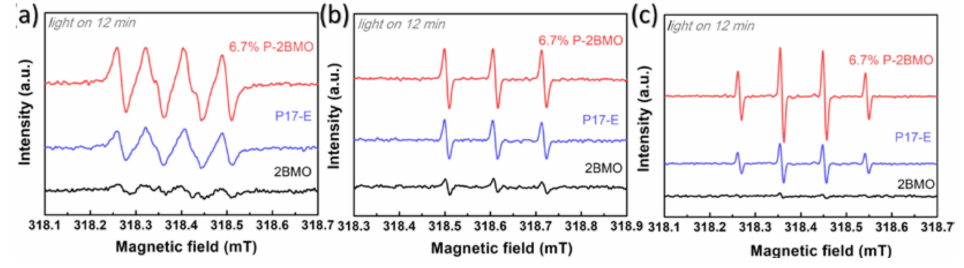
Figure 7. Electron spin resonance (ESR) spectra of 5,5-Dimethyl-1-pyrroline-N-oxide (DMPO)- • O 2– ( a ),